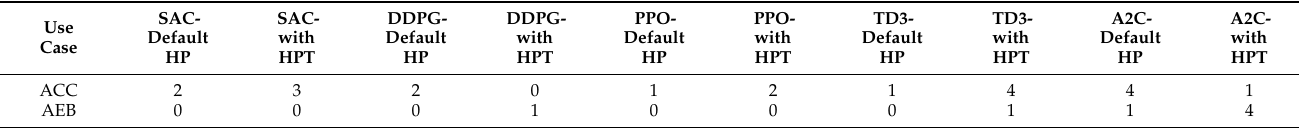
Table 8. Comparison of RL agents in finding faults in ACC.